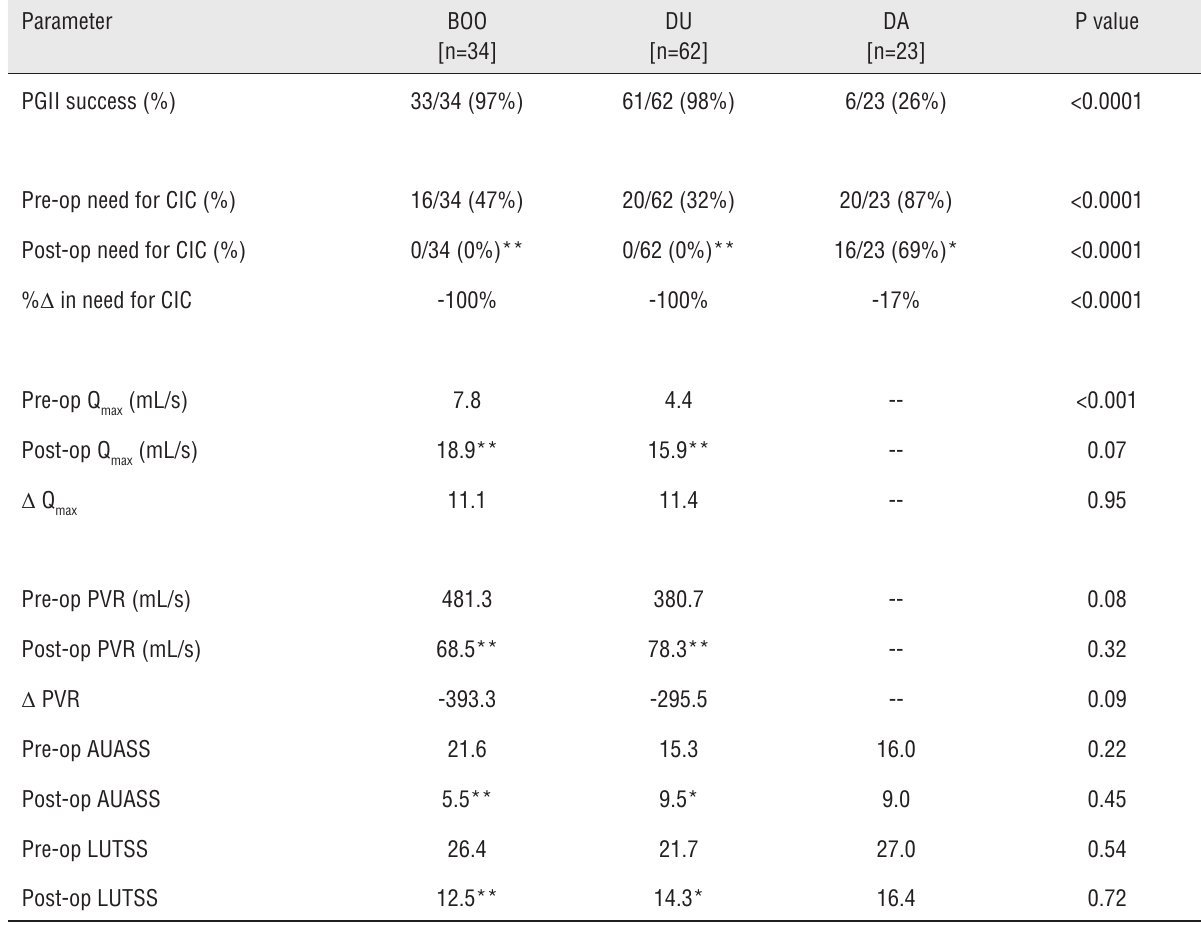
Table 3 - comparison between Pre- and Post-Operative